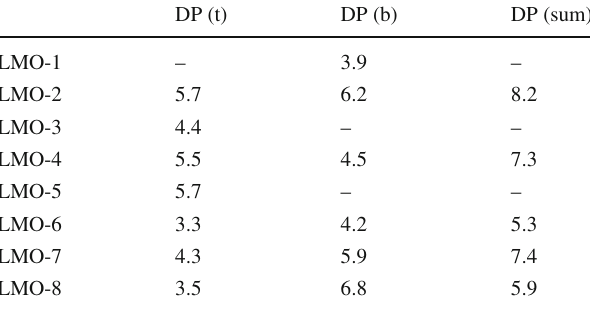
Table1 LightyieldforLDtop(t),LDbottom(b)andthesumofthetwo light detectors in the case of bare crystals. LMO-1 to LMO-4 are in the baseline configuration (bottom LD spaced 0.5mm and top LD spaced 4mm). LMO-5 to LMO-8 are in the “gravity assisted” configuration (bottom LD spaced 0.5mm and top LD leaned on crystal). The missing values correspond to LDs we discarded for the analysis (LMO-1 top LD corresponds to LMO-5 bottom LD). The associated uncertainty is the width of the LY distribution